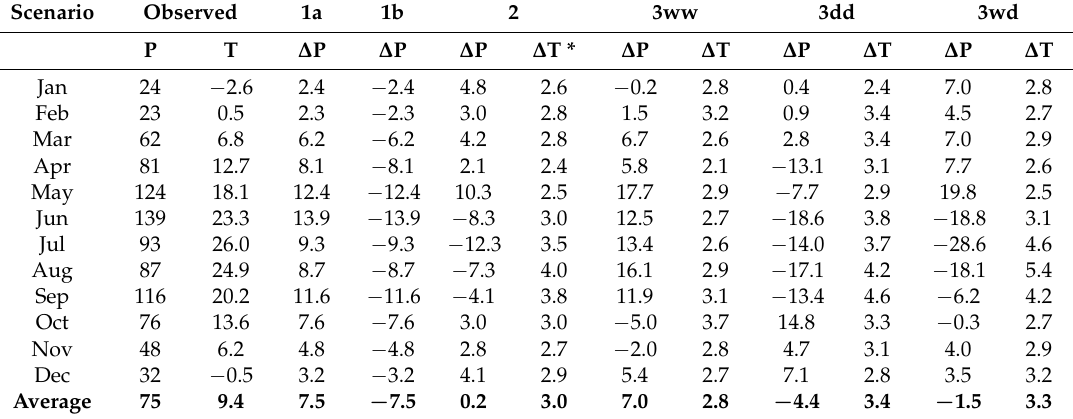
Table 2. Monthly mean precipitation (P, mm) and temperature (T, ◦ C) for observed weather at